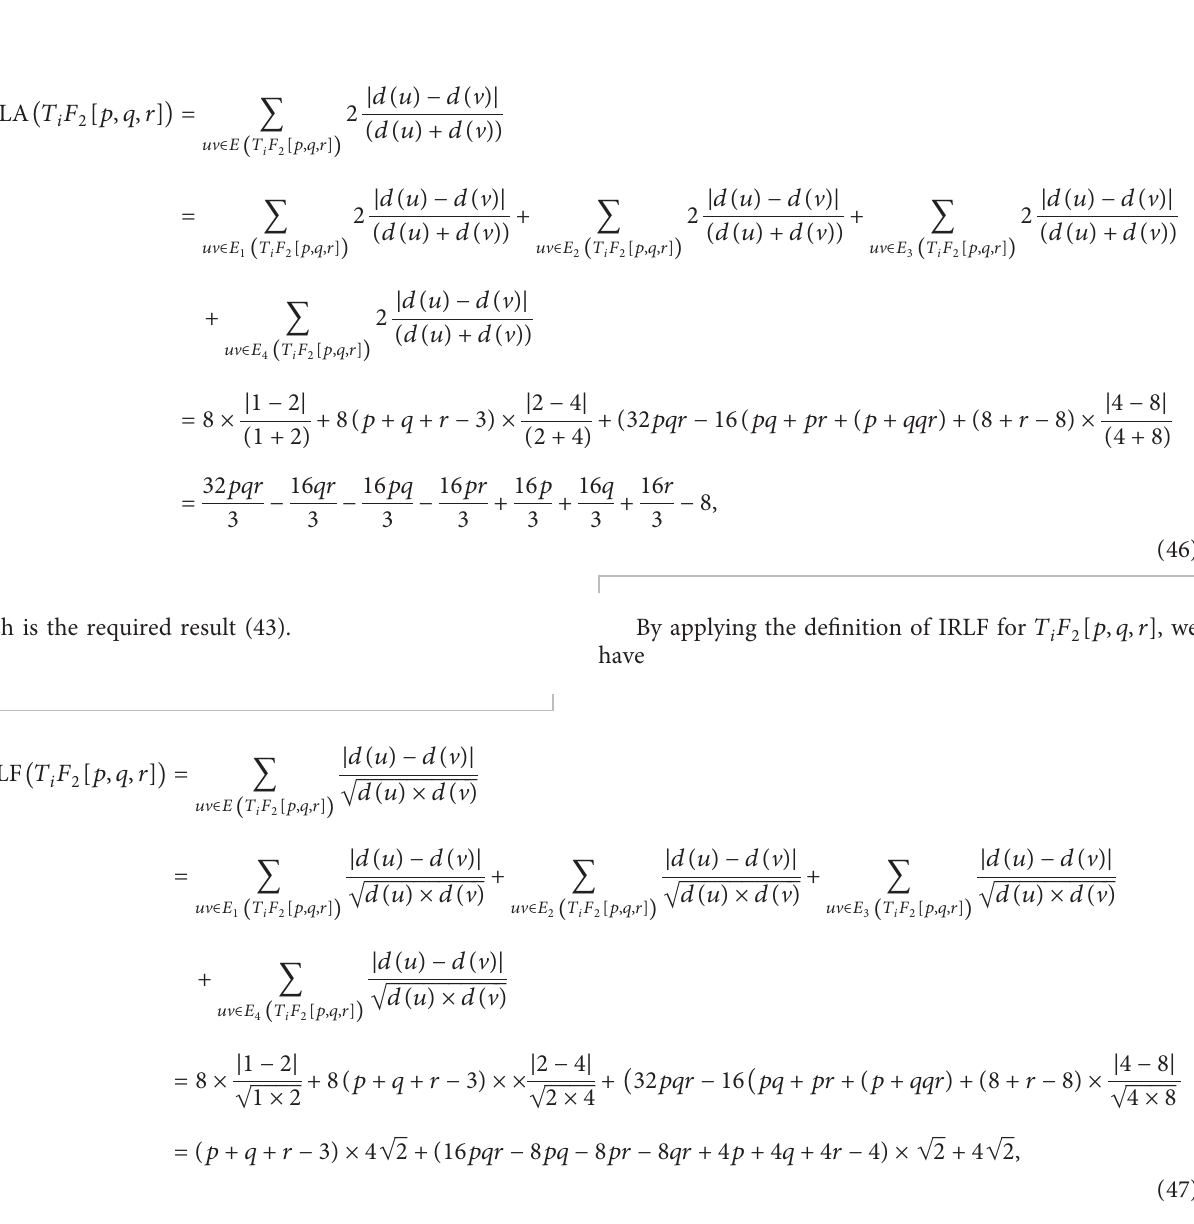
, and IRGA for crystallographic structure Cu 1